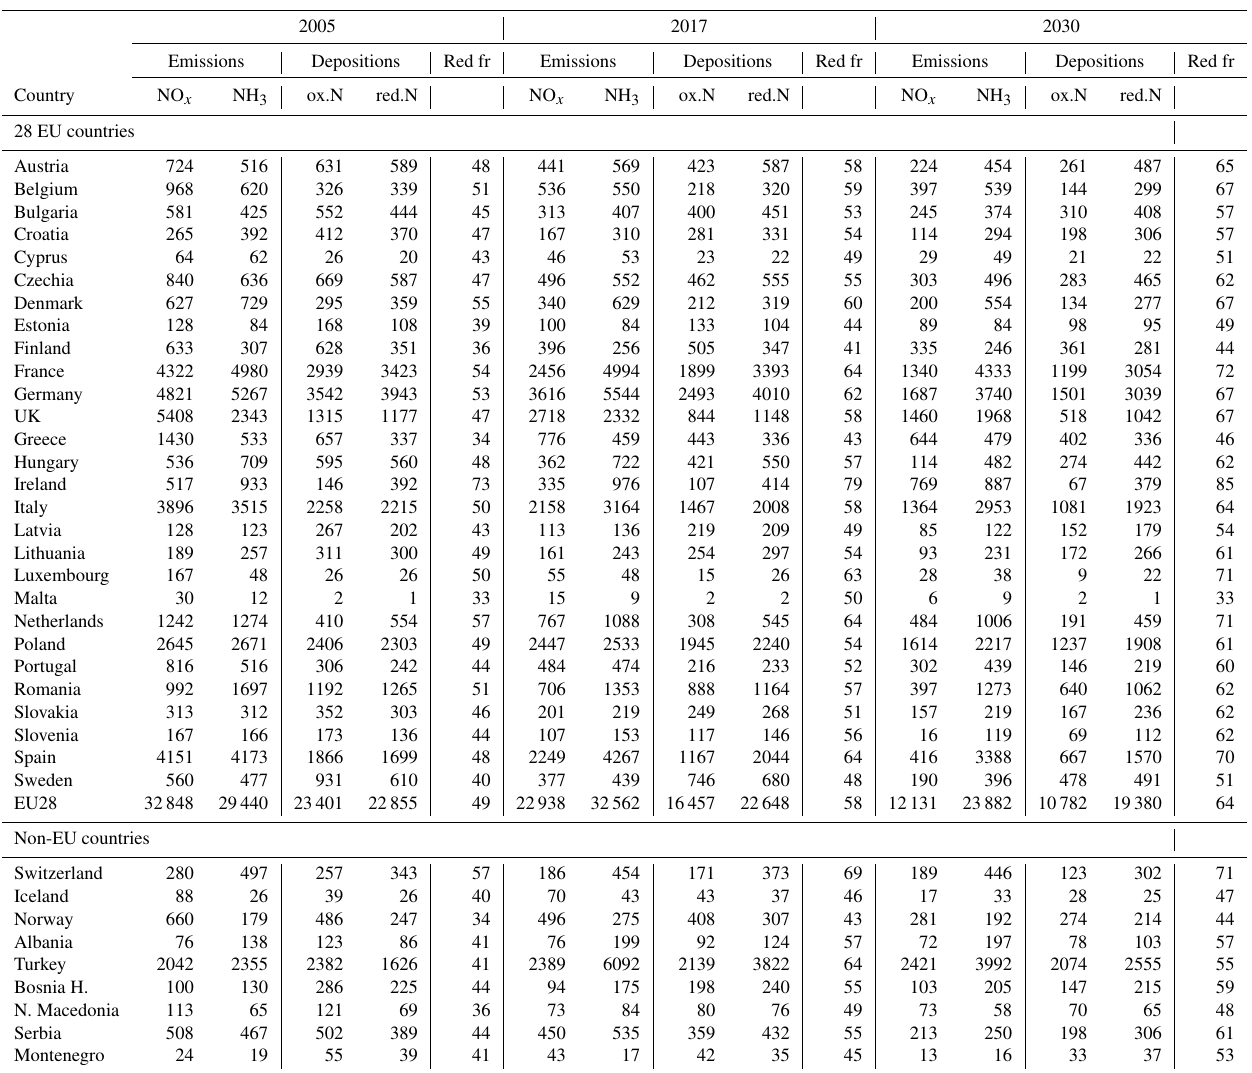
Table 1. Emissions of NO x and NH 3 , depositions of oxidised and reduced nitrogen, and the ratio of reduced to total (reduced + oxidised) deposition of nitrogen (Red fr). Emissions and deposition are listed in 100Mg of N. Bosnia H. is Bosnia and Herzegovina, and N. Macedonia is North Macedonia. UK is the United Kingdom of Great Britain and Northern